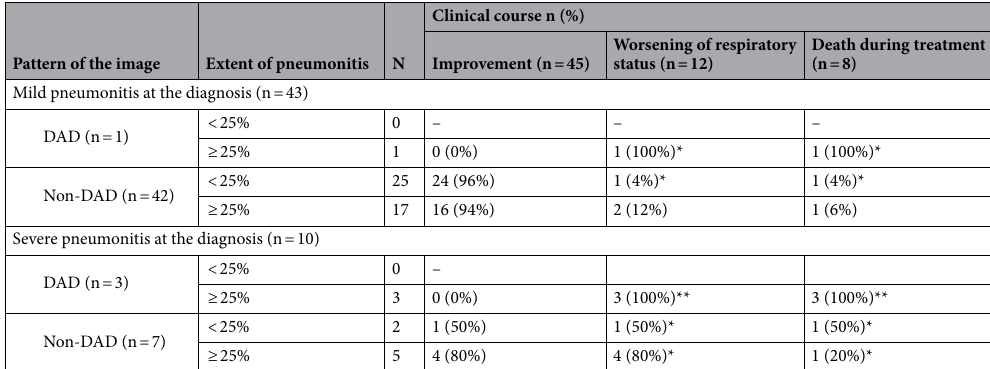
Table 4. Clinical courses of patients who developed pneumonitis stratified by the extent of pneumonitis and the pattern of the image. Abbreviations: DAD diffuse alveolar damage. *One patient develops worsening of respiratory status and dies during the treatment. **Three patients develop worsening of respiratory status and die during the treatment.